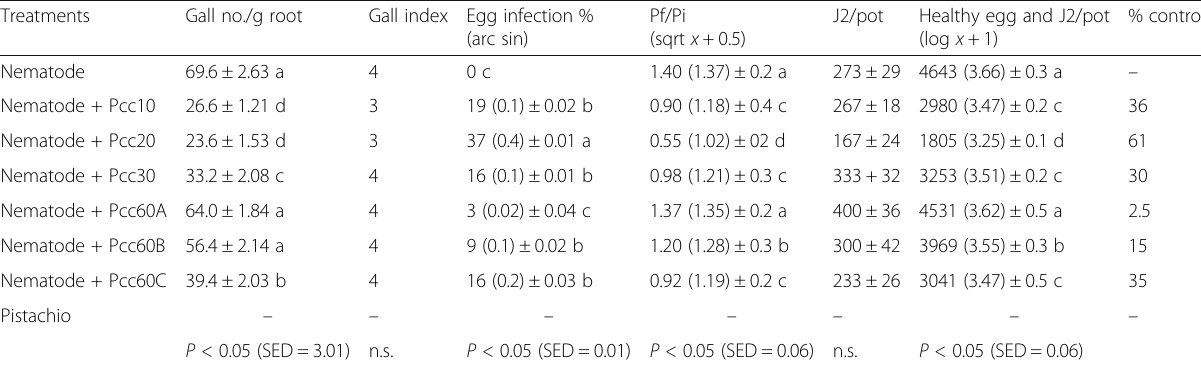
Table 1 The effect of Pochonia chlamydosporia var. chlamydosporia isolates on Meloidogyne javanica populations, survival of the fungus isolates and their colonization of roots of pistachio after 4 months in the greenhouse ( n = 5 means ± S.E) Treatments Gall no./g root Nematode Nematode + Pcc10 Nematode +